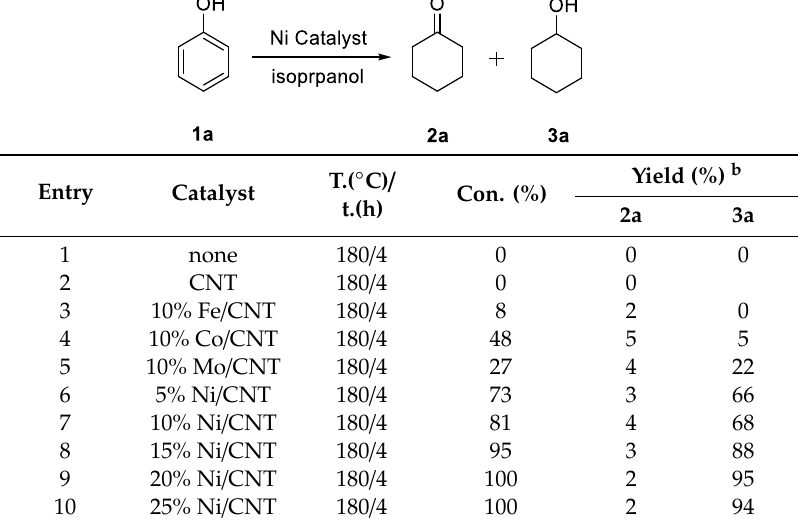
Table 1. Chemical and physical properties of CNT-supported Ni catalysts.